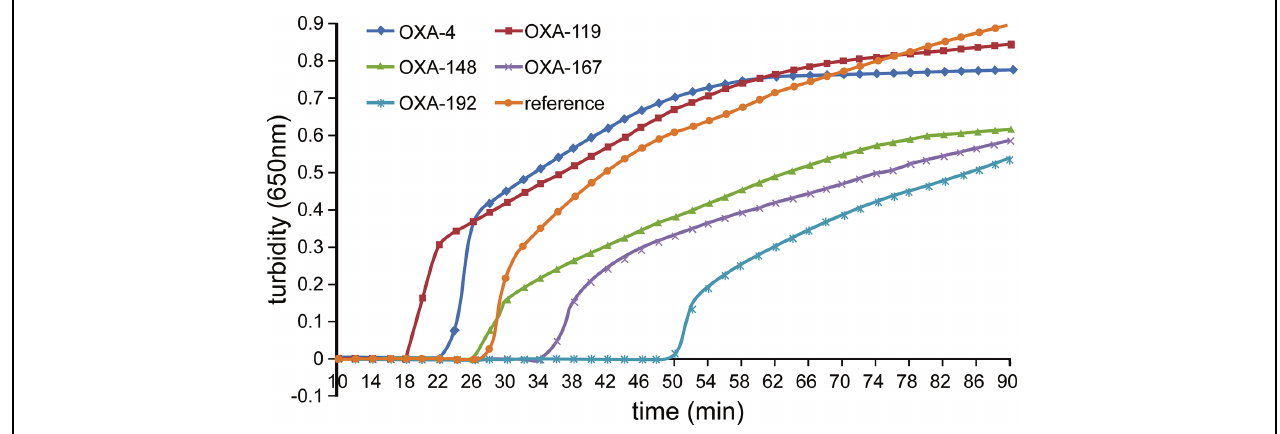
FIGURE 1 | Five sets of primers were used to amplify the indicated target genes of Acinetobacter baumannii under the same conditions. Turbidity was monitored using a Loopamp real-time turbidimeter by measuring the absorbance at 650 nm every 6 s. The OXA-4 primer set was chosen as the most appropriate primers for the rapid detection of A.